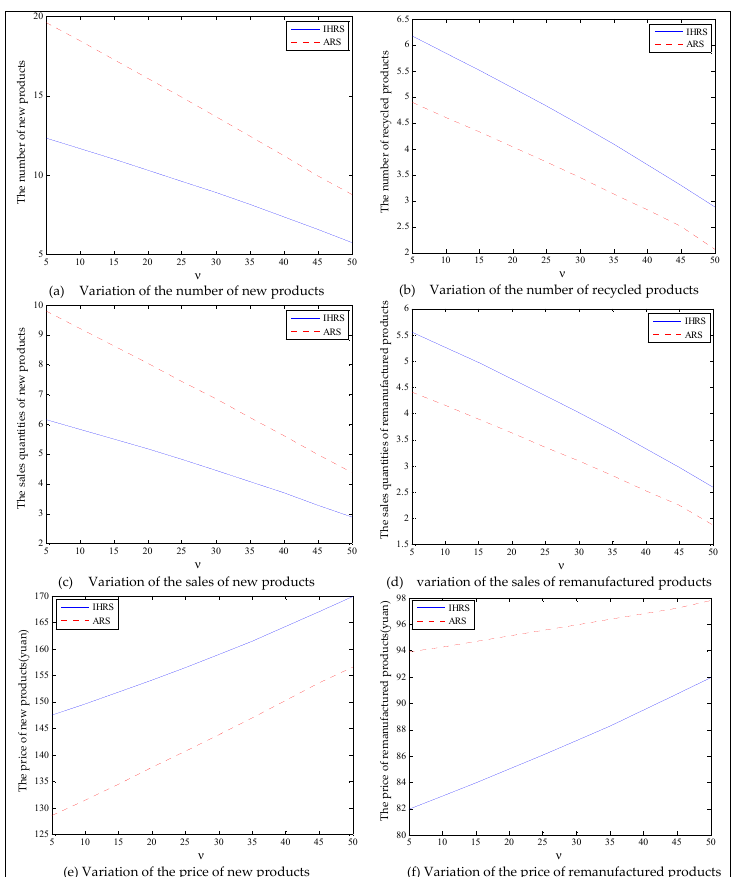
Figure 8. The variation of equilibrium strategies in Case 2 of Section 6.1.